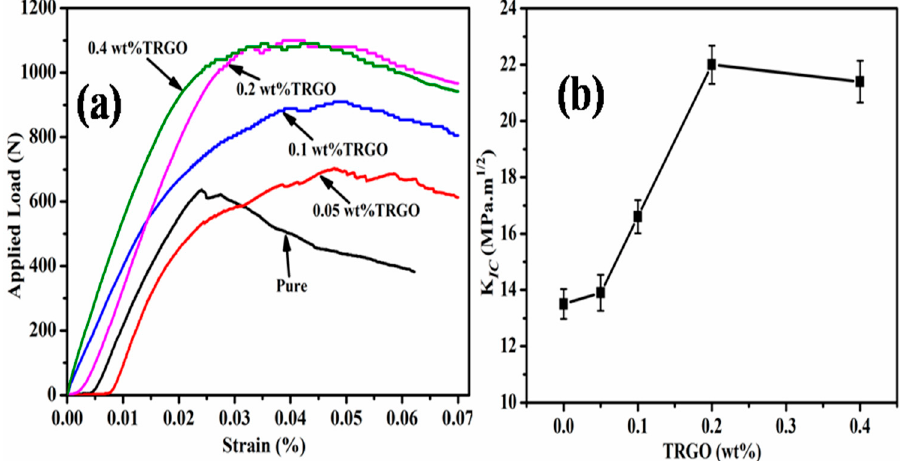
Figure 7. ( a ) Load vs. displacement curves and ( b ) K IC vs. TRGO content of the prepared CF/epoxy composites. Table 3. Overall in-plane fracture behaviour of the prepared CF/epoxy composites. wt % of TRGO P Q